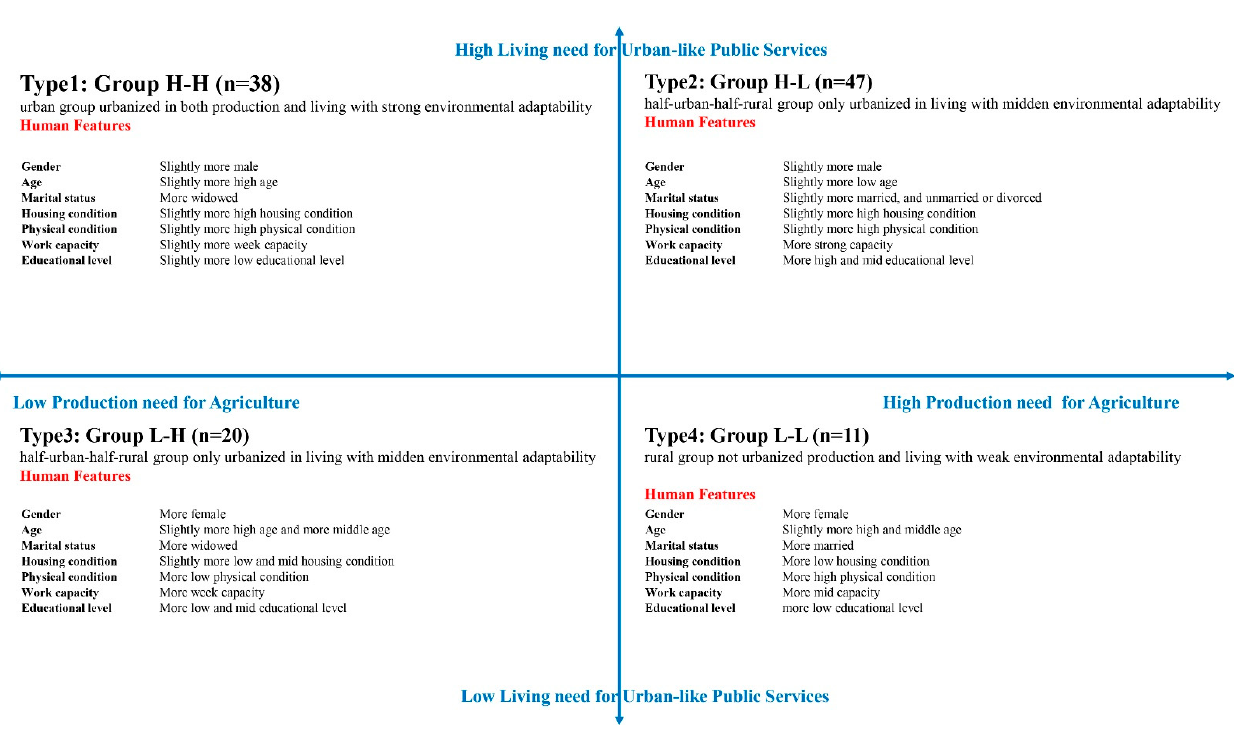
Figure 5. Decomposition model of urbanization features based on population-attribute (Source: Author). Group H-H, an urban group urbanized in both production and living with strong environmental adaptability: the proportion of males is a little higher, the age is older, the health condition is better, most of them have an independent house, the widow propor- tion is significantly higher, and work capacity and educational levels are both middling; Group H-L, a half-urban-half-rural group only urbanized in living with middle en- vironmental adaptability: the proportion of males is a little higher, the age is younger, and their health condition is better; most of them have an independent house, and most still have a spouse, with an overall strong work capacity and high education levels; Group L-H, a half-urban-half-rural group only urbanized in production with mod- erate environmental adaptability: the proportion of women is greatly high, with more